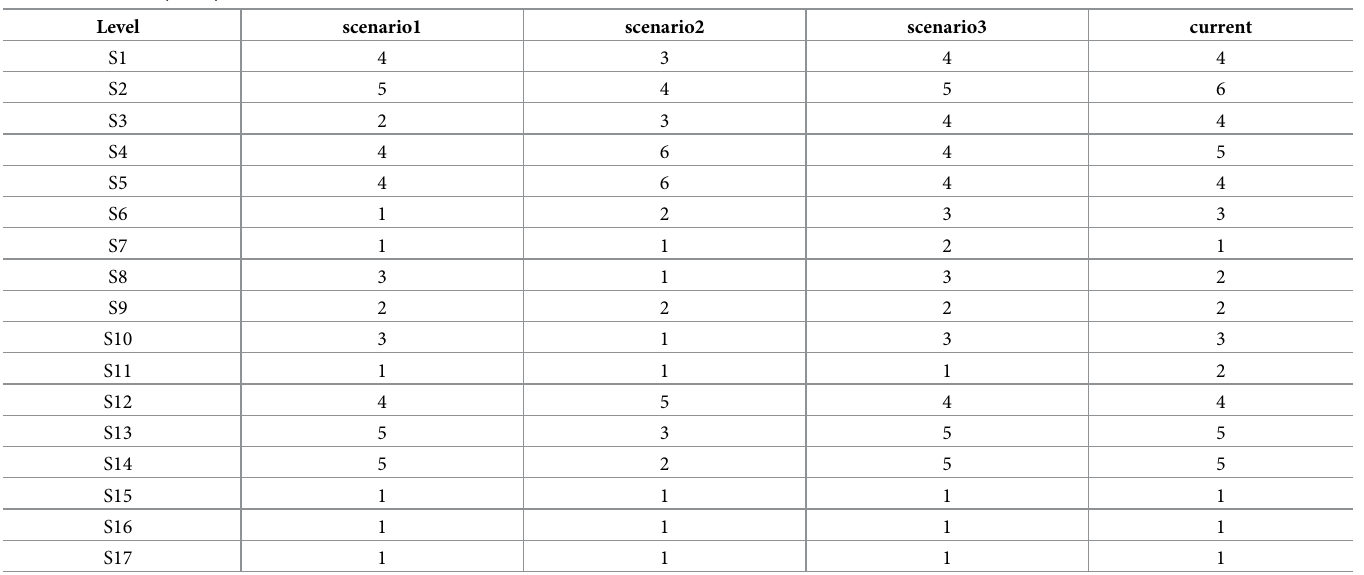
Table 13. Sensitivity analysis of ISM